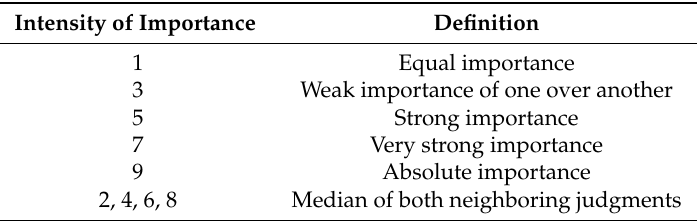
Table 1. Intensity scale of